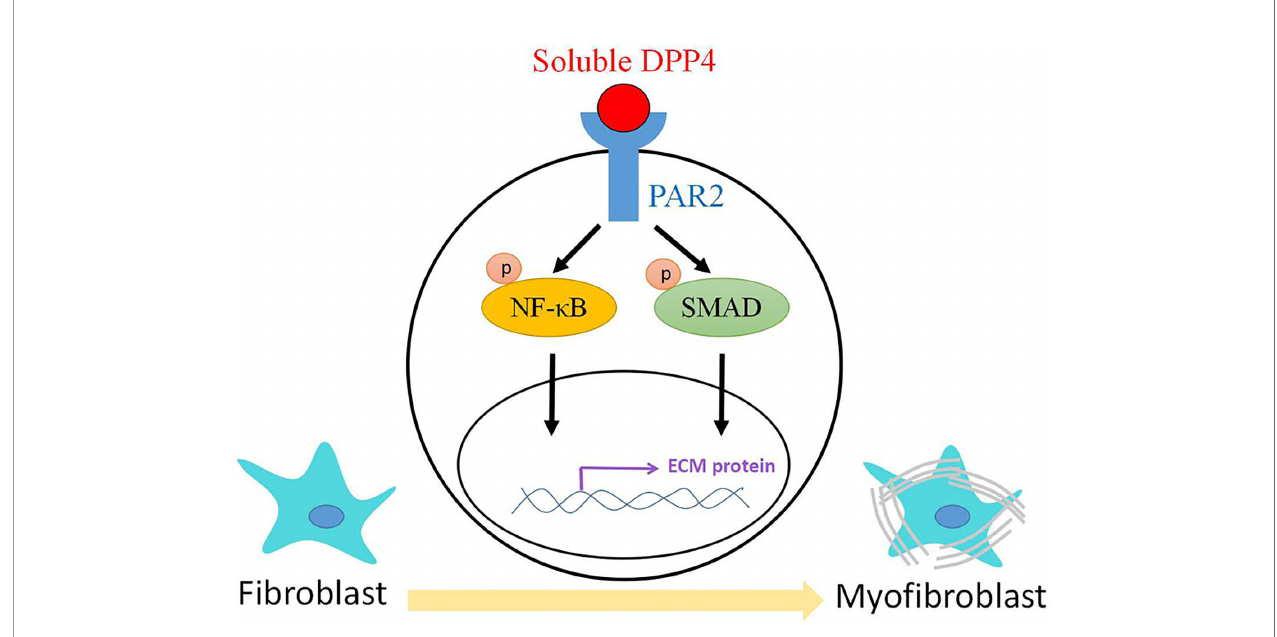
FIGURE 8 | The mechanisms of soluble